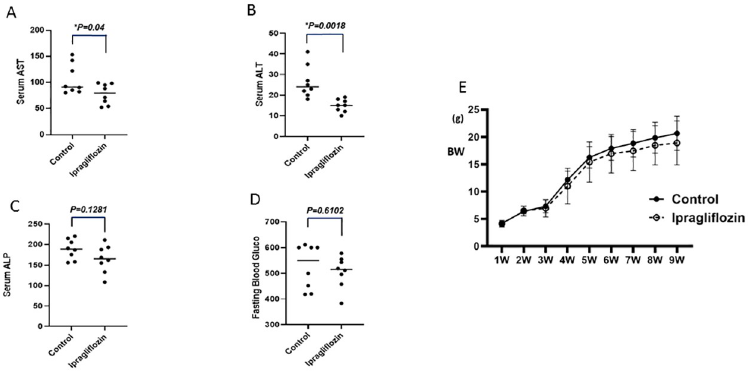
Fig 1. Effects of ipragliflozin on (A) ALT, (B) AST, (C) ALP, (D) fasting blood glucose, and (E) body weight (BW) in the livers of STAM mice. Data are shown as the mean ± SD [ � P < 0.025 vs. control group (n = 8) or ipragliflozin group (n = 8)].